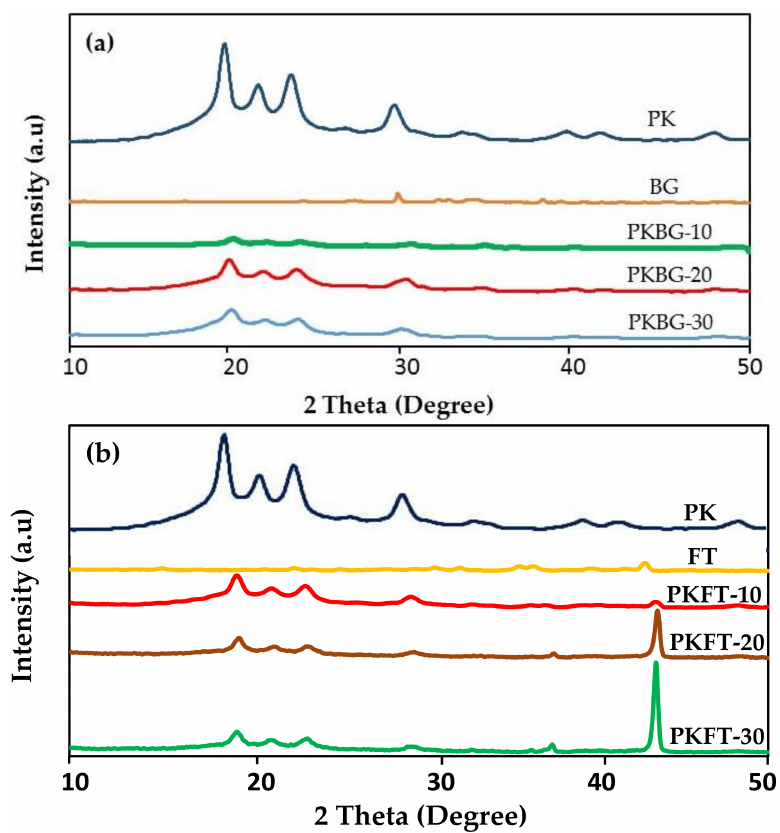
Figure 1. XRD patterns showing the effect of adding BG and FT nanoparticles on the crystallinity of PEEK: ( a ) nanocomposites filled with BG nanoparticles and ( b ) nanocomposites filled with FT nanoparticles. Table 1. PEEK/bioglass and PEEK/forsterite nanocomposites formulations (percentage by weight). Matrix Bioactive Filer Content Code Sample PEEK (wt.%) BG